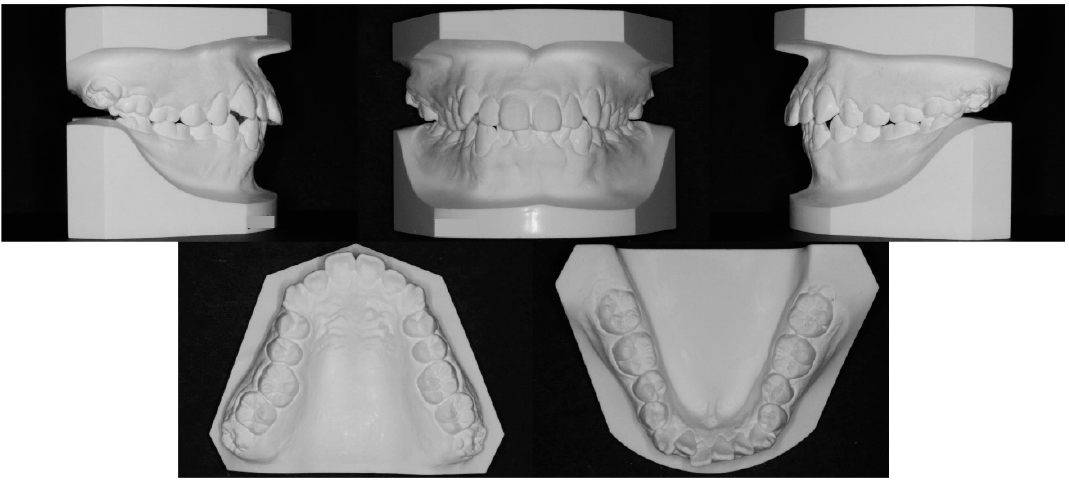
Figure 2. Pretreatment dental casts.